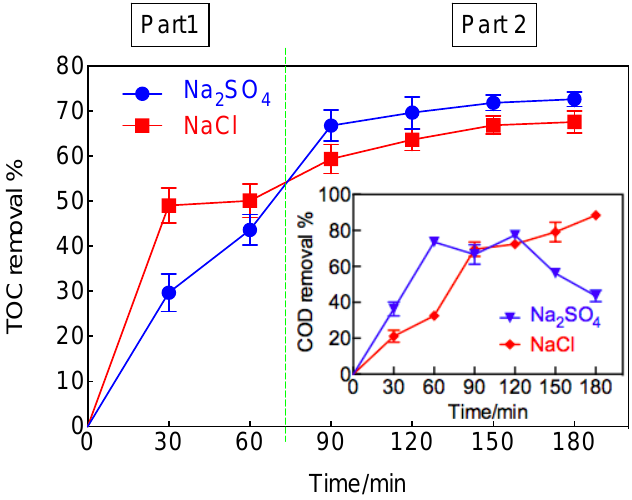
Figure 6. TOC and COD removal of RhB wastewater in the recycling-flow 3D electro-reactor system (NaCl and Na 2 SO 4 as electrolytes, initial concentration is 2 g / L; RhB wastewater initial concentration is 100 mg / L; volume is 500 mL; initial pH is 7; voltage is 7 V; HRT is 20 min).